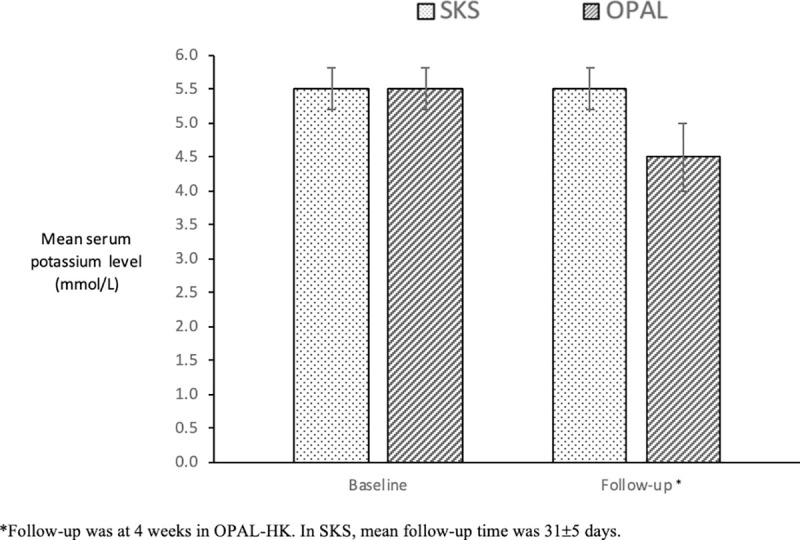
Change in mean potassium level from baseline to follow-up.* Follow-up was at 4 weeks in OPAL-HK. In SKS, mean follow-up time was 31±5 days.